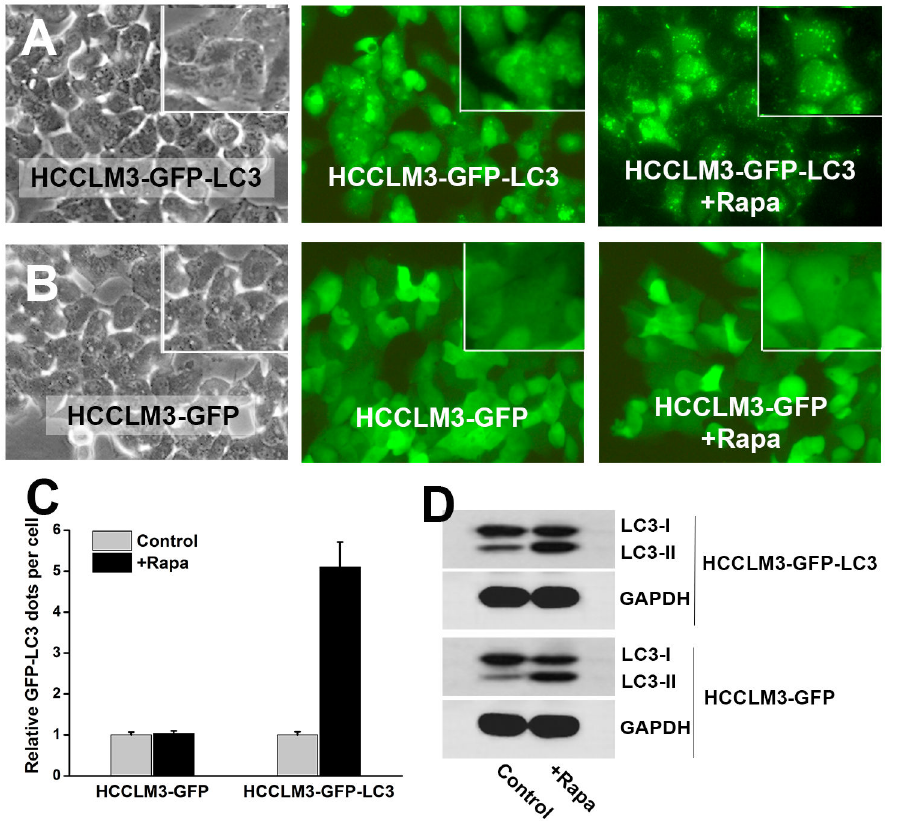
Figure 3. Generation of stable GFP-LC3 expressing HCC cell line. (A, C) Highly metastatic HCCLM3 cell line stably expressing GFP-LC3 reporter gene (HCCLM3-GFP-LC3) was generated via lentivirus-mediated GFP-LC3 overexpression. The HCCLM3-GFP- LC3 cells exhibited a large number of GFP-LC3 dots after rapamycin treatment (+Rapa). (B, C) HCCLM3 stably expressing GFP (HCCLM3-GFP) served as Control. The HCCLM3-GFP cells displayed no GFP-LC3 dots after rapamycin treatment (+Rapa). (D) Western blot analysis of LC3 showed that rapamycin induced intense autophagy in both HCCLM3-GFP-LC3 and HCCLM3-GFP. doi: